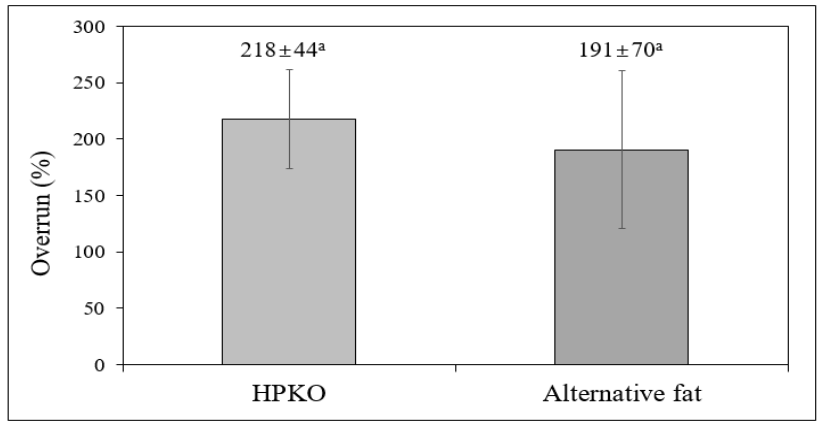
Figure 4. Overrun (%) of whipping creams prepared with hydrogenated palm kernel oil (HPKO) and alternative fat (HPKO:RAMR = 6:4 blend, w / w ).